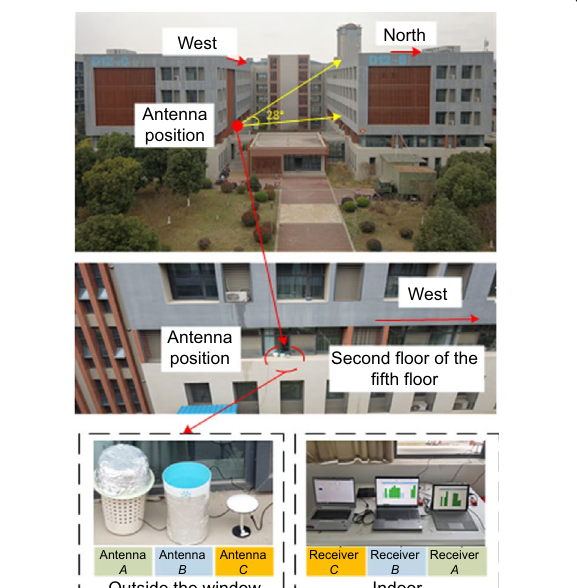
Fig. 7 Experimental setup. The top panel demonstrates the panoramic view of antenna placement environment. The middle panel exhibits the close shot of antenna placement environment. The bottom panel illustrates the three antennas and three receivers